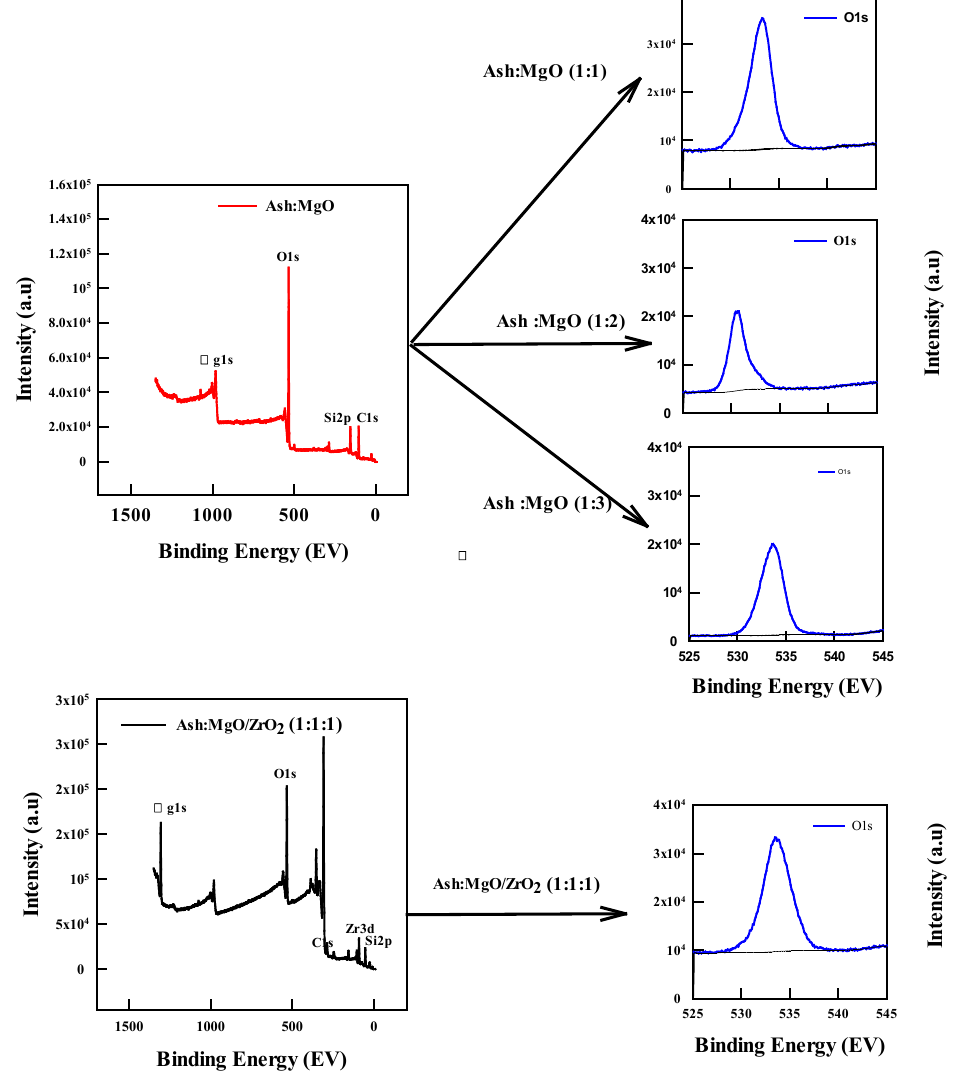
Figure 2. XPS profile for Ash:MgO (1:1, 1:2, 1:3) and Ash:MgO/ZrO 2 (1:1:1). Table 1. Elemental weight percentage analysis using